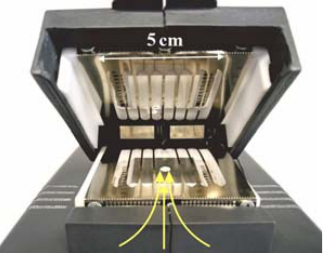
Figure 2. Sample preparation module toaster-type design.